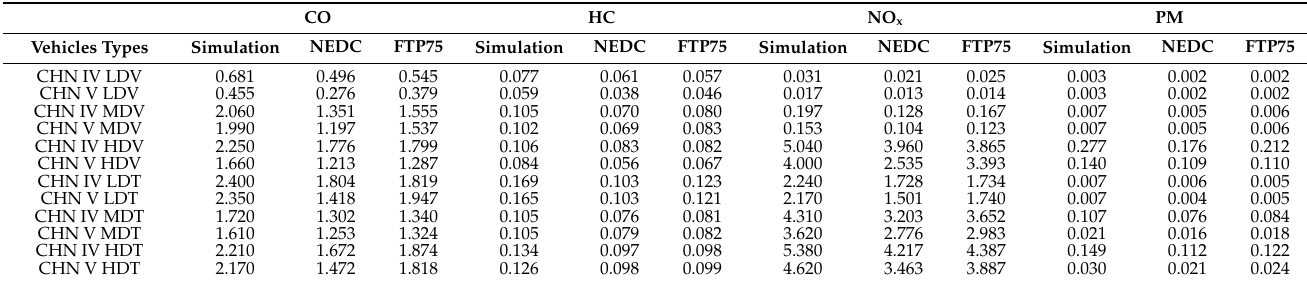
Table 6. The average pollutant emission factors of tested vehicles (unit: